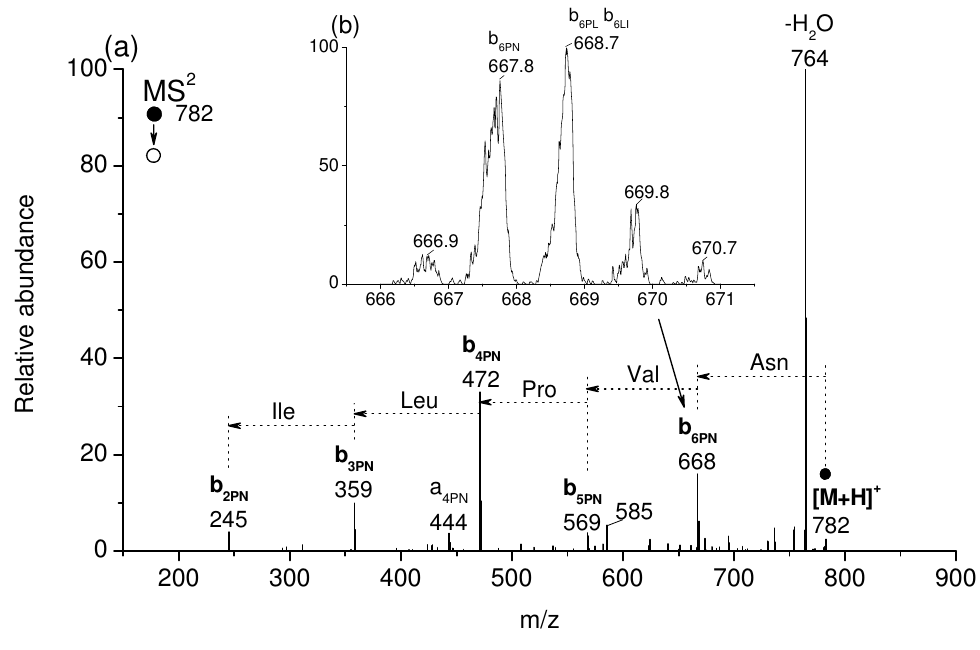
Fig. 2 (a) Product-ion spectra of the protonated cyclic peptide produced by one stage of MS/MS; (b) zoom scan spectrum in the range of m/z 665.5-671.5. The parent ion is marked with “ •